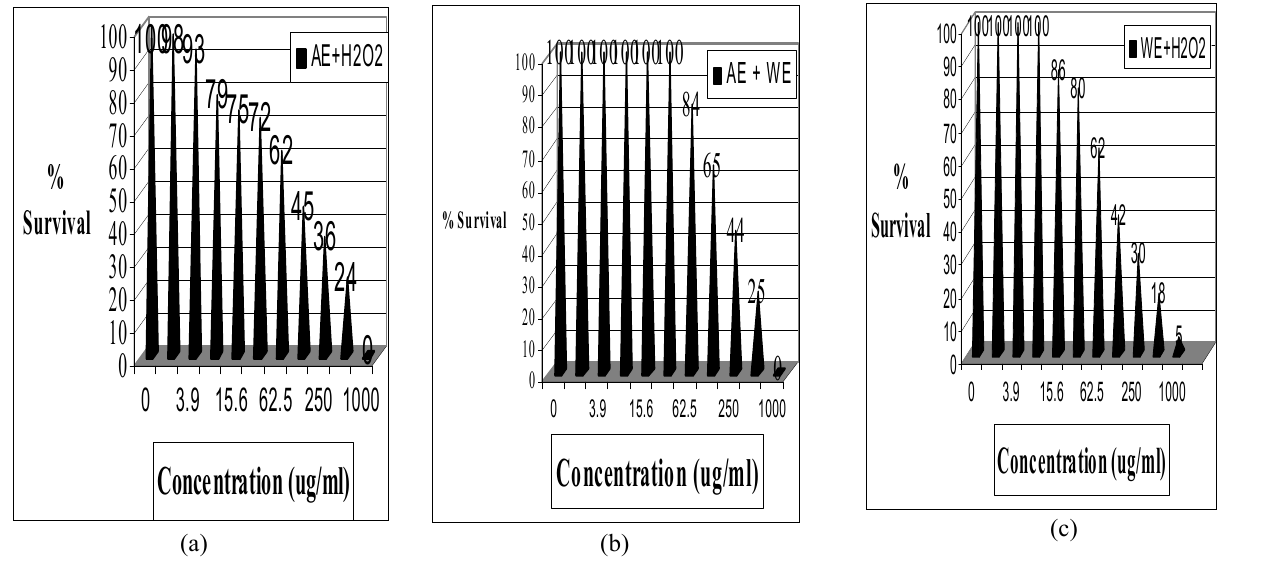
Figure 2 : Cellular response of MCF-7 breast cancer cell line to a 48 hour exposure to (a) water extract of black seed and hydrogen peroxide (WE + H mix of alcohol and water extracts of black seed (AE + WE) in complete RPMI medium and the FDA assay.